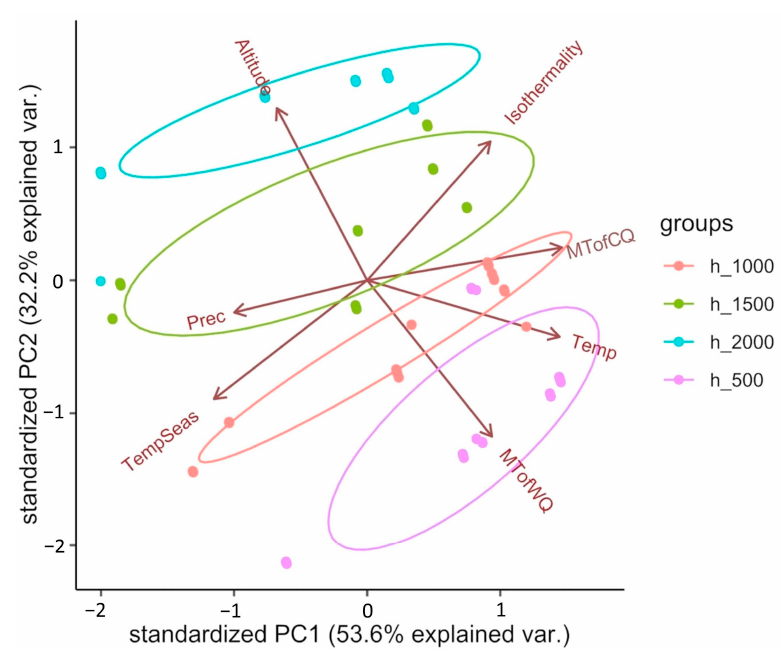
Figure 1. Principal component analysis (PCA) plot of seven environmental factors.